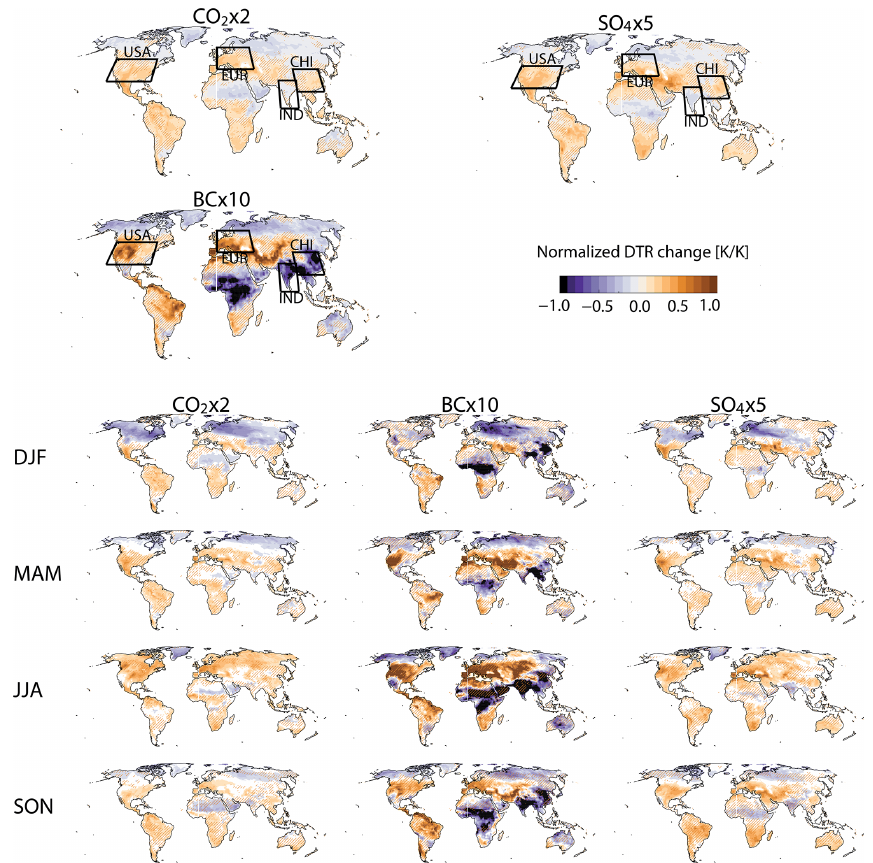
Figure 3. Multimodel median change in DTR, normalized by the global mean temperature change [KK − 1 ] for the three experiments. Larger upper maps show annual mean changes, while smaller lower maps show seasonal changes. Hatching indicates areas where less than 75% of the models agree on the sign of the change. Annual maps include indications of the focus regions of this study.